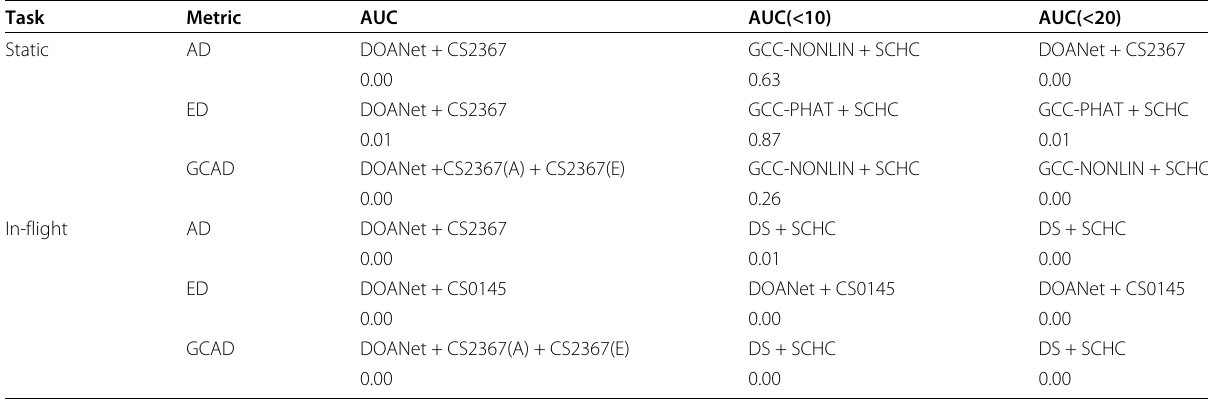
Table 10 Summary of the best techniques for different tasks along with p values of two-sample t test at 0.05 significance level when comparing against best baseline method. AD azimuthal angle deviation, ED elevation angle deviation, GCAD great-circle angular